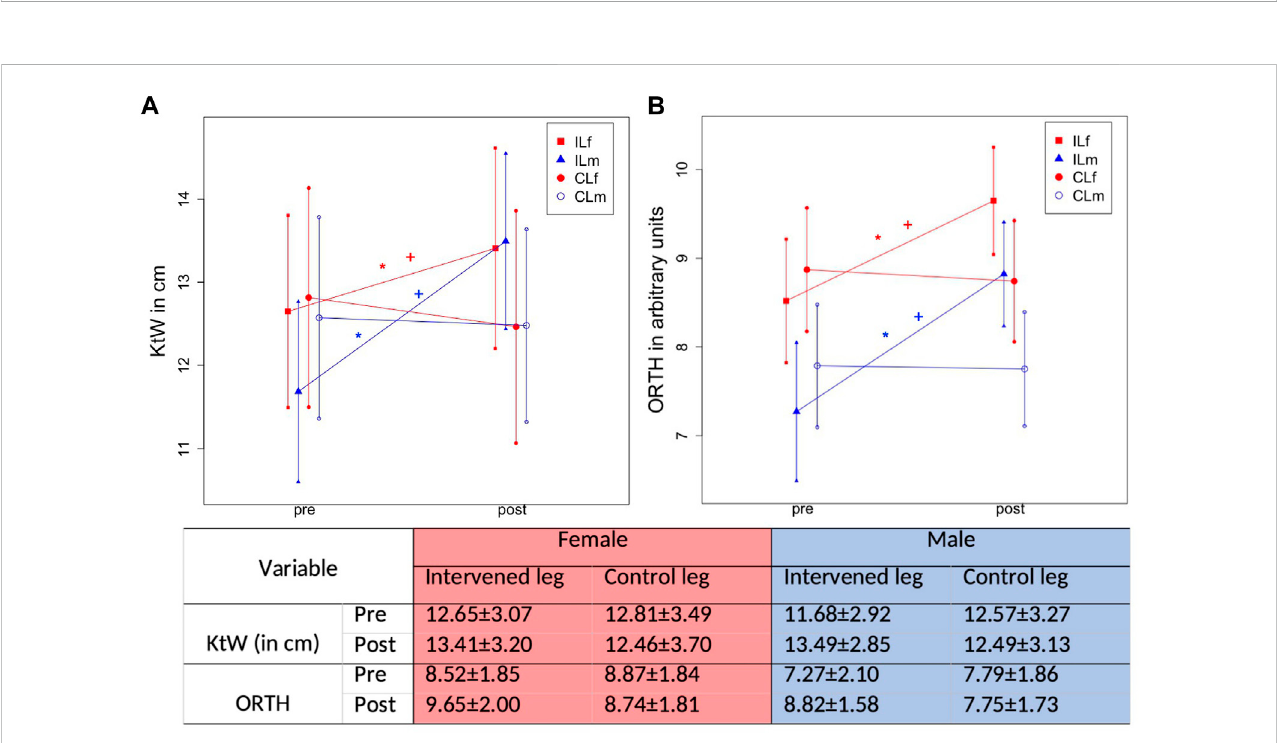
FIGURE 6 Graphical illustration of progression in ROM in IL and CL due to 1-h daily stretching training in plantar fl exor in KtW (ROM testing using the knee to wall test) (A) and ORTH (ROM testing using the goniometer of the orthosis) (B) considering sex. The * illustrates a signi fi cant difference to the control leg, the + illustrates a signi fi cant difference to the other